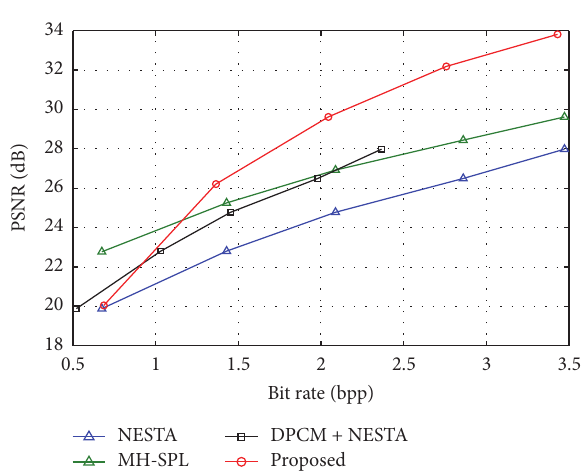
Figure 6: Comparison of average rate-distortion curves for the various reconstruction